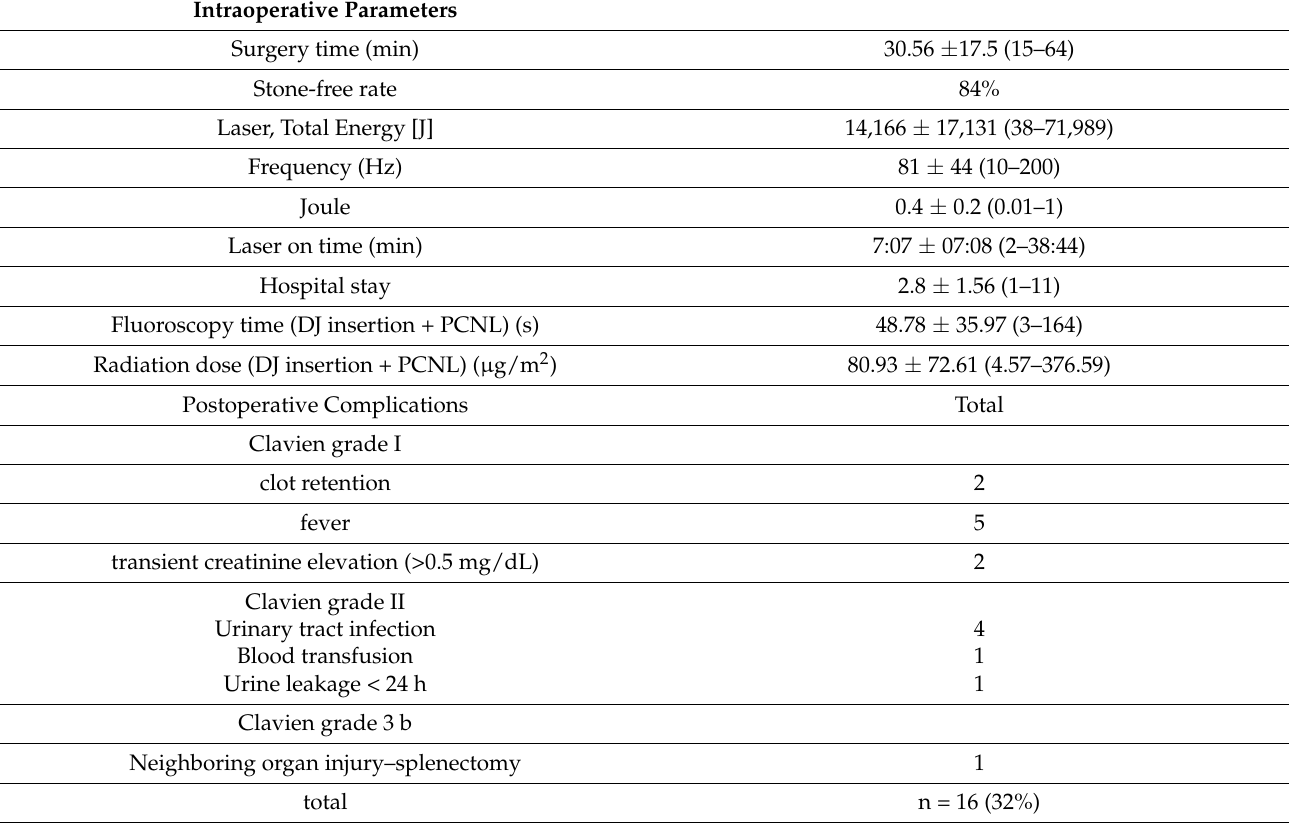
Table 2. Intra- and postoperative